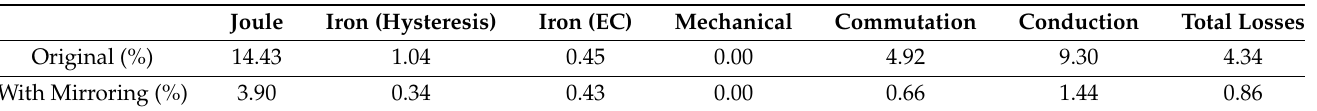
Figure 12. Mirroring technique principle applied using the clustering method. This approach allows for a much more accurate division of one of the machine modes without modifying the total number of interest points selected. Table 2 presents the results when applying this method using the second variant of the clustering technique for the same application described before. Table 2. Comparison between the proposed cycle reduction techniques. Deviations are calculated in relative value compared to cycle loss values.